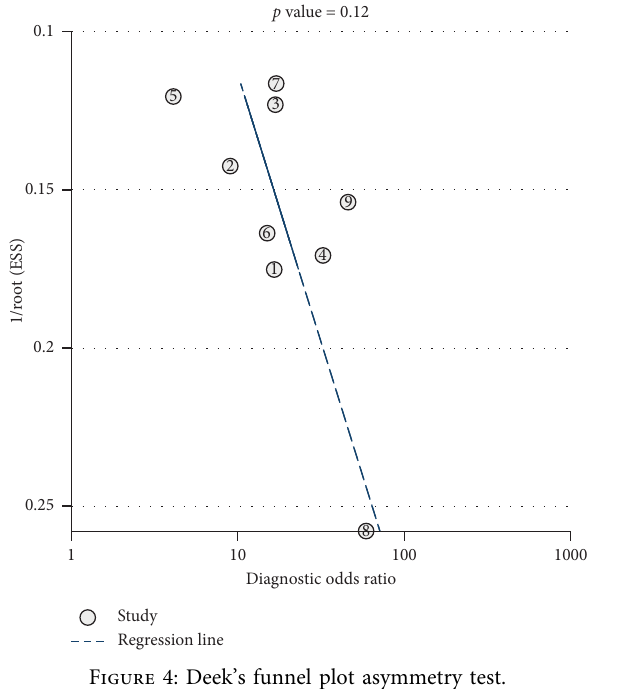
Figure S1: proportion of studies with low, high, or unclear